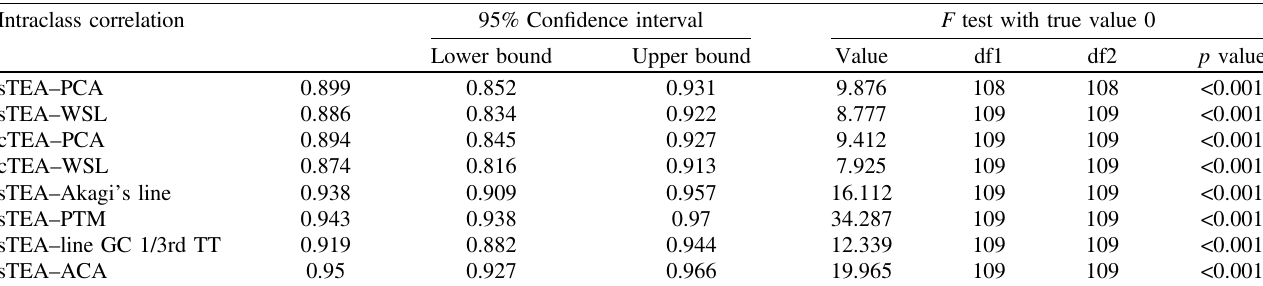
Table 7. Interobserver reliability among different axis